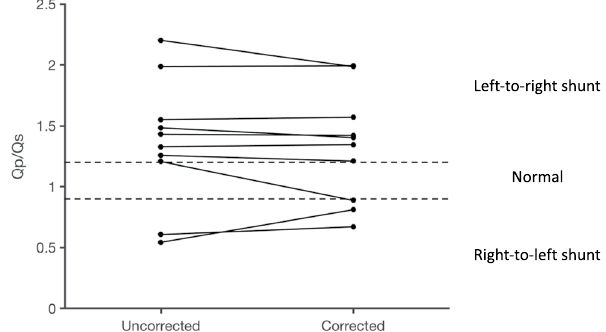
Figure 3. Stationary tissue background correction in patients with a verified shunt. The figure shows Qp/ Qs before and following linear stationary background correction using Vendor 1. No patient was reclassified as normal following correction. The patient that is classified as a left-to-right shunt prior to correction and a right-to-left shunt following correction had a complex heart condition including a communication between the descending aorta and the lung, and pulmonary regurgitation. The pulmonary backward volume was not quantifiable before background correction, why this patient is correctly classified a right-to-left shunt following background correction.